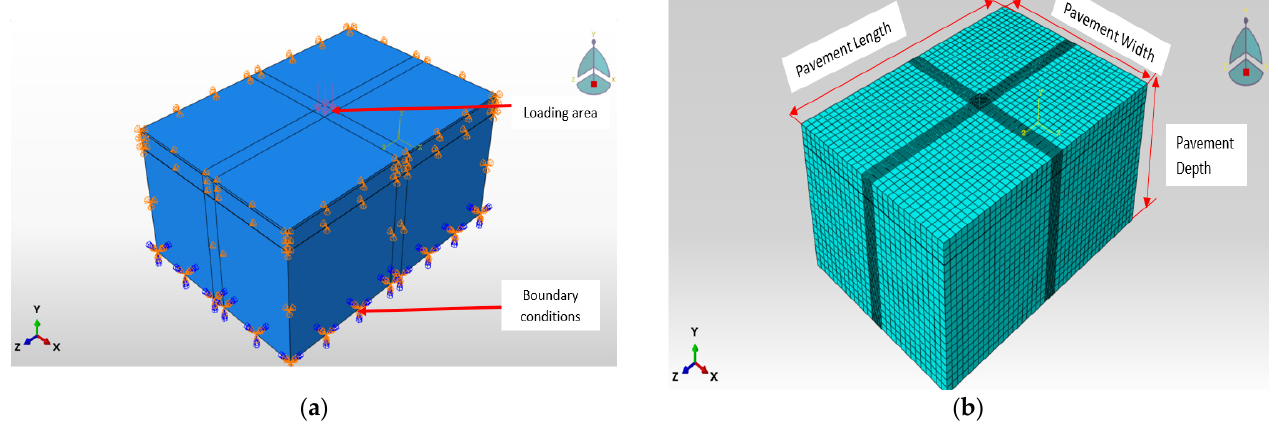
Figure 1. ( a ) Pavement model showing boundary conditions and loading area; ( b ) pavement model showing the mesh elements.